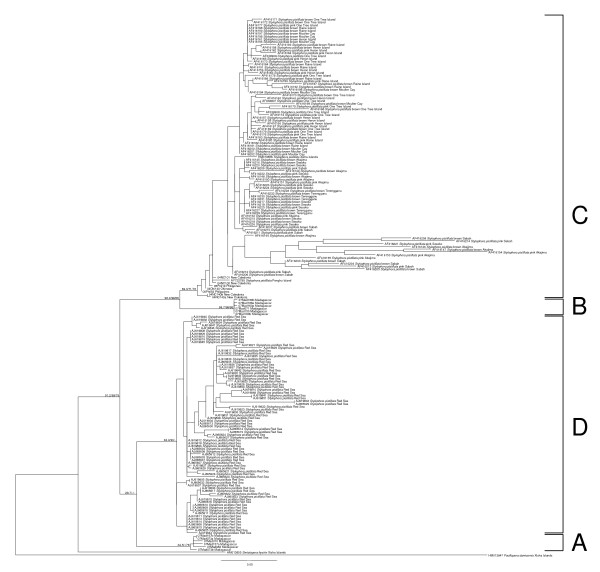
ITS1 molecular phylogeny of the genus Stylophora. In addition to ITS1 sequences from selected individuals of species A, B and C, data from published articles [69,12,35,13] and from an unpublished study by Feng You and Hui Huang [GenBank: HM013847, HM013855, HM013856] were included in the haplotree (generated with PhyML using the TPM2+G model suggested by jModelTest).